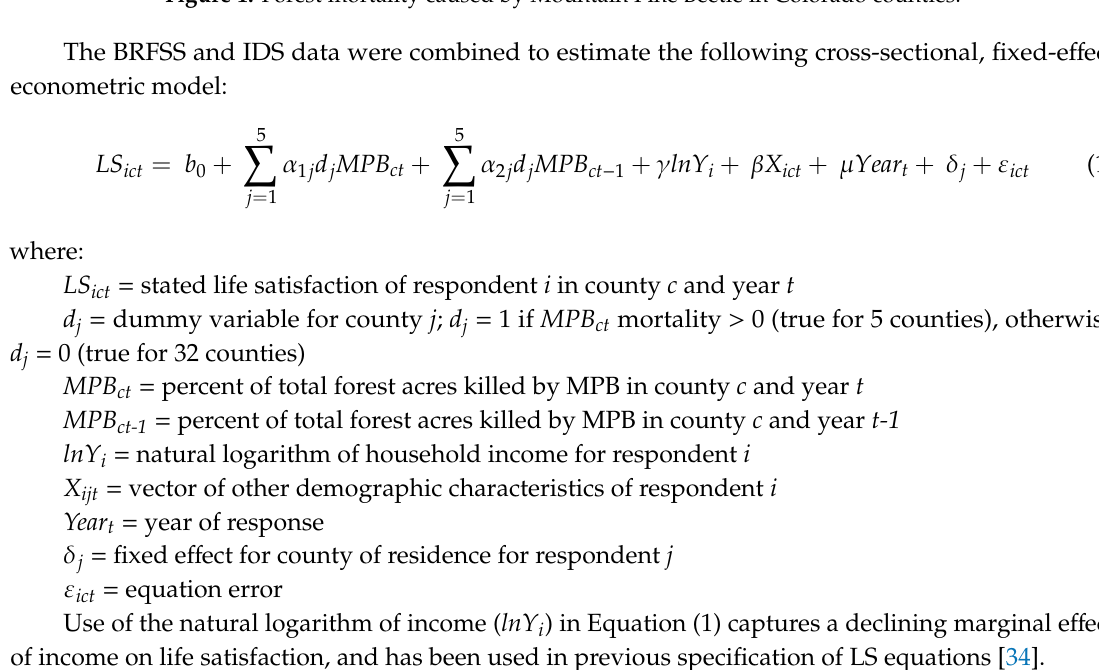
Figure 1. Forest mortality caused by Mountain Pine Beetle in Colorado counties.